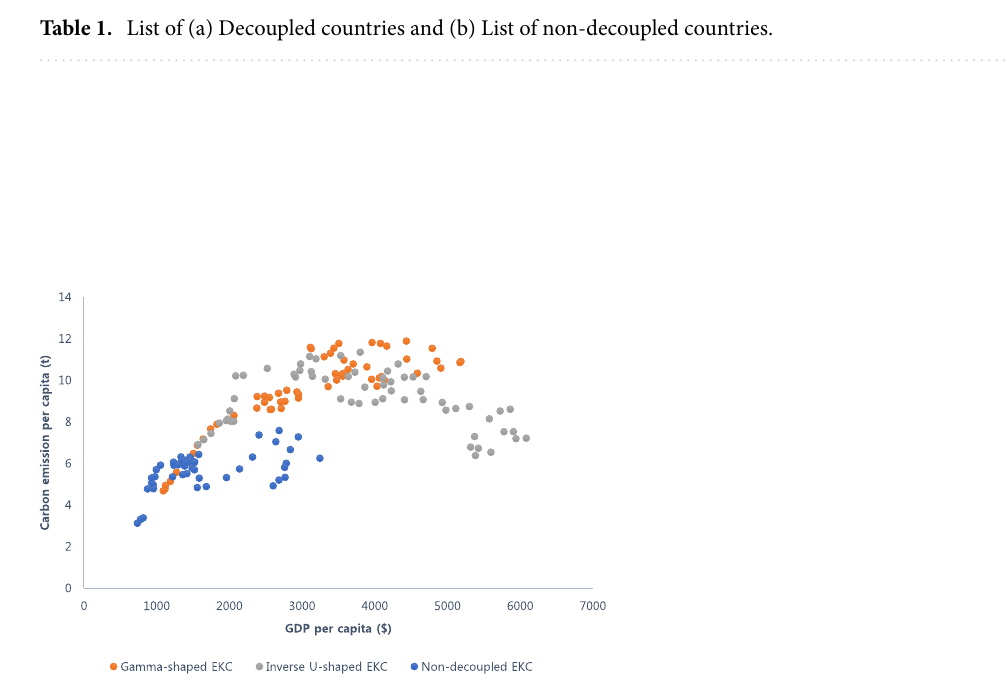
Figure 1. Distribution of the environmental Kuznets curve (EKC) of countries. Gamma-shaped and inverse U-shaped distributions are depicted as orange squares and gray triangles, respectively, and EKC of non- decoupled countries are depicted as blue circles. GDP, gross domestic